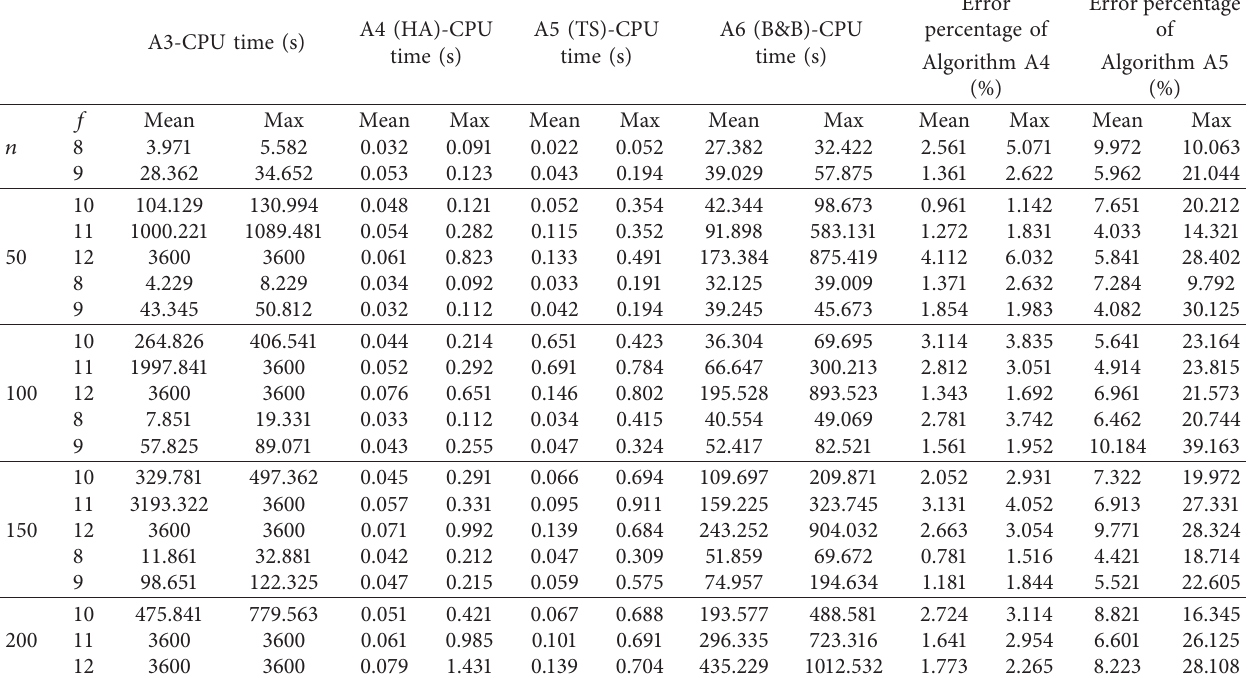
Table 3: Results of